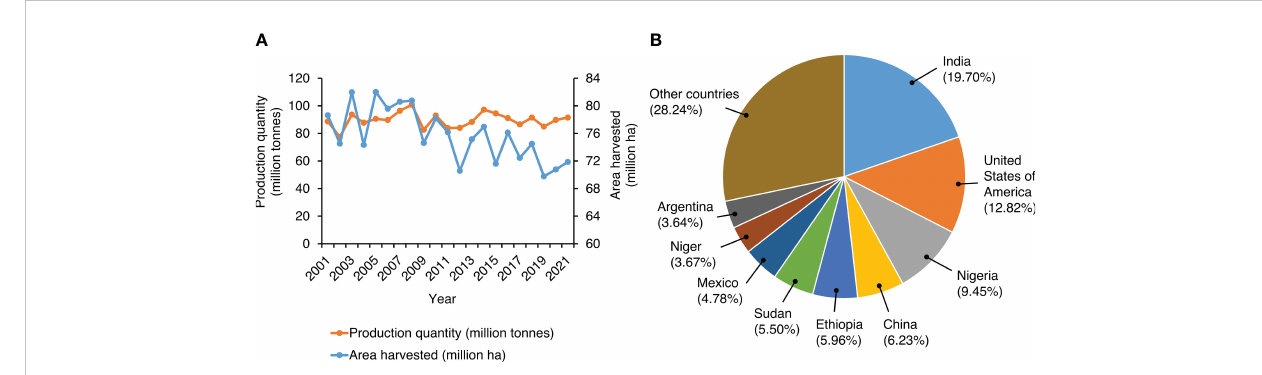
FIGURE 1 Global trends in millets production and cultivation. (A) Worldwide millet production in the last two decades. The graph represents production quantity (million tons) and the area under cultivation (million ha) from 2001 to 2021. Data represent the sum of values reported for millets